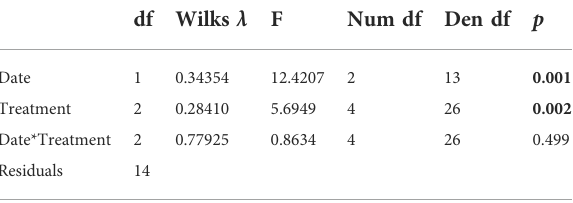
TABLE 3B Effect of population and date on principal component scores of temperature-sensitive transcripts in Dicosmoecus gilvipes. Results of MANOVA tests to determine the the effect of the additional warming between the two Angelo